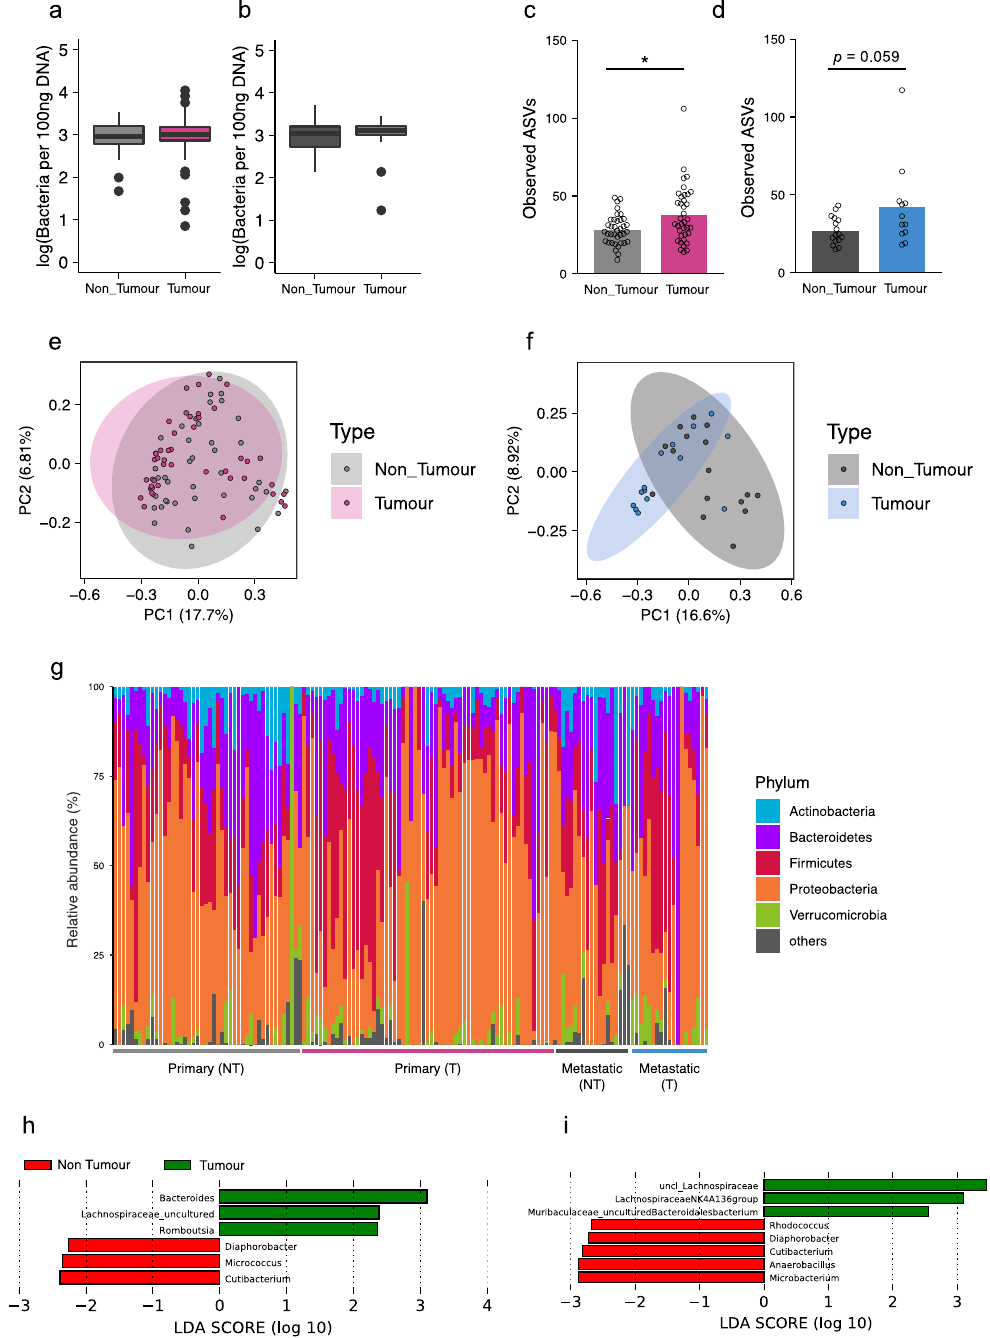
Figure 2. Microbial signature of tumour and non-tumour tissues dissected from primary and metastatic liver cancers. ( a , b ) Bacterial load in the non-tumour and tumour regions of primary ( a ) or metastatic liver cancers ( b ). Bacterial load was assessed by qPCR for 16S rRNA gene. The Y axis indicates the number of bacteria as the logarithm (base 10). ( c , d ) Species richness (Observed ASVs) of the microbiota in the non-tumour and tumour regions of primary ( c ) or metastatic liver cancers ( d ). ( e , f ) Principal component analysis of unweighted UniFrac distances among the microbiota in the non-tumour and tumour regions of primary ( e ) or metastatic liver cancers ( f ). ( g ) The bacterial composition of the microbiota at the phylum level in the non-tumour (NT) and tumour (T) regions of primary and metastatic liver cancers. Each bar represents an individual sample. ( h , i ) Discriminating taxa between the non-tumour and tumour regions of primary ( h ) or metastatic liver cancers ( i ) determined by LefSe analysis 15 . The prefix of “uncl_” stands for unclassified bacterium on the SILVA_132 reference database (SSURef_NR99_132_SILVA) 36–38 . Each boxplot represents median, interquartile range (IQR), the lowest and highest values within 1.5 IQRs of the first and third quartiles, and the outliers shown with dots (primary liver cancers: n = 37/group; non-tumour regions of metastatic liver cancers: n = 12; tumour regions of metastatic liver cancers n = 16). Each bar represents mean, and the values of each sample are indicated with dots. Significant differences are indicated at the top of the panels (* p < 0.05; Wilcoxon rank sum